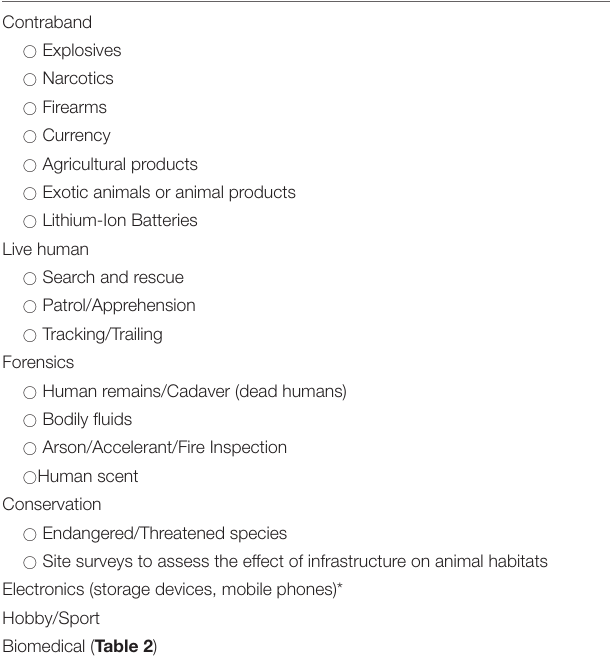
TABLE 1 | A selection of examples demonstrating the growing list of detection dog